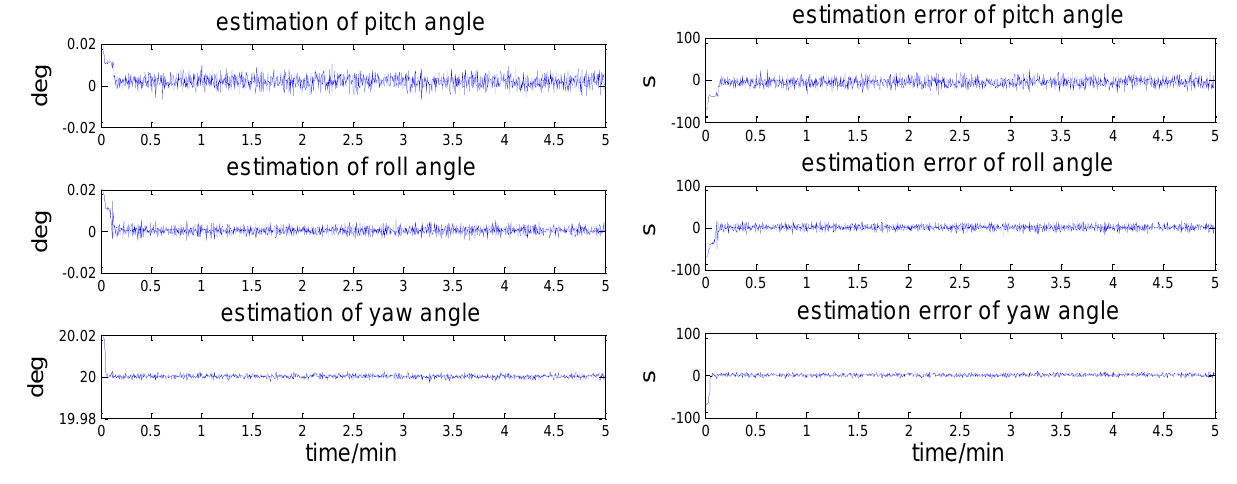
Figure 8. The attitude estimation and its